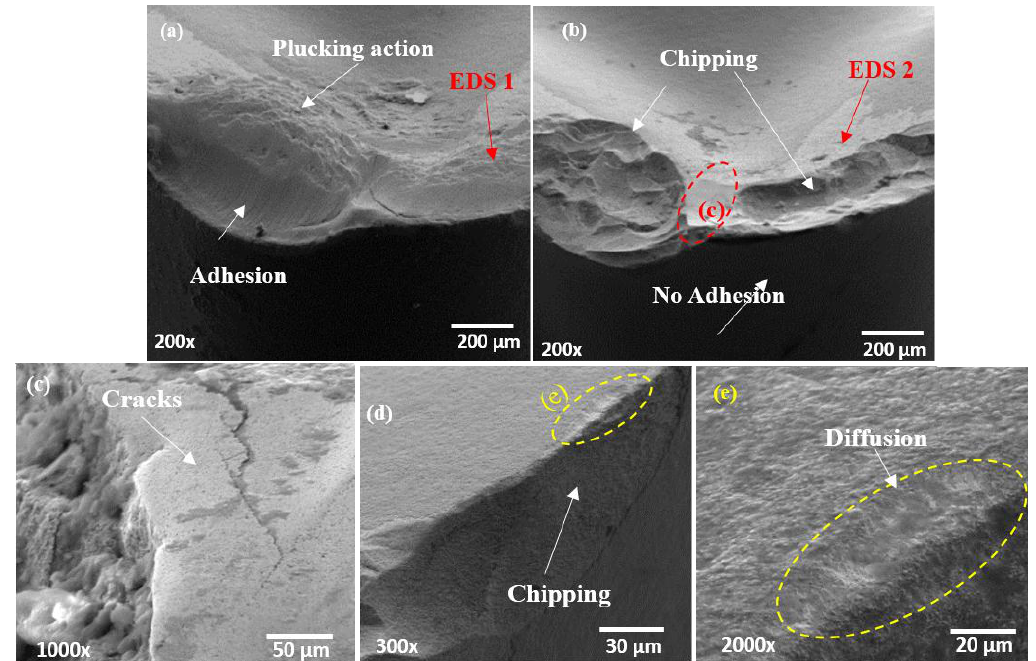
Figure 7. SEM images of PVD AlTiN coated insert after machining SDSS: ( a ) cutting tool before etching; ( b ) cutting tool after etching; ( c – e ) cutting tool with different magnifications.